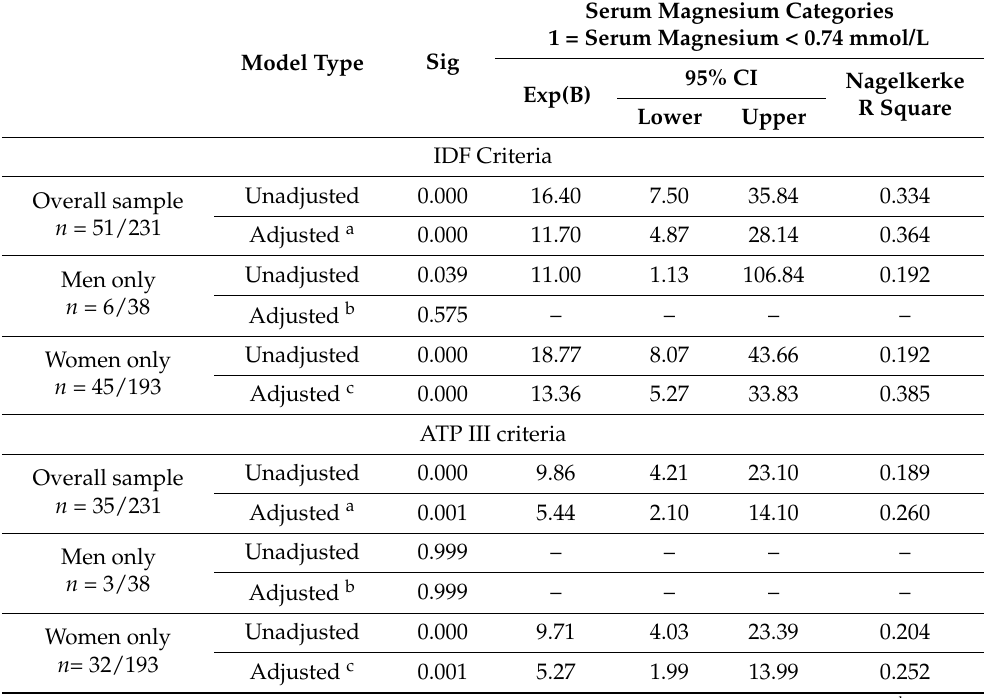
Table 6. Binary logistic regression analysis with hypomagnesemia as the independent variable.